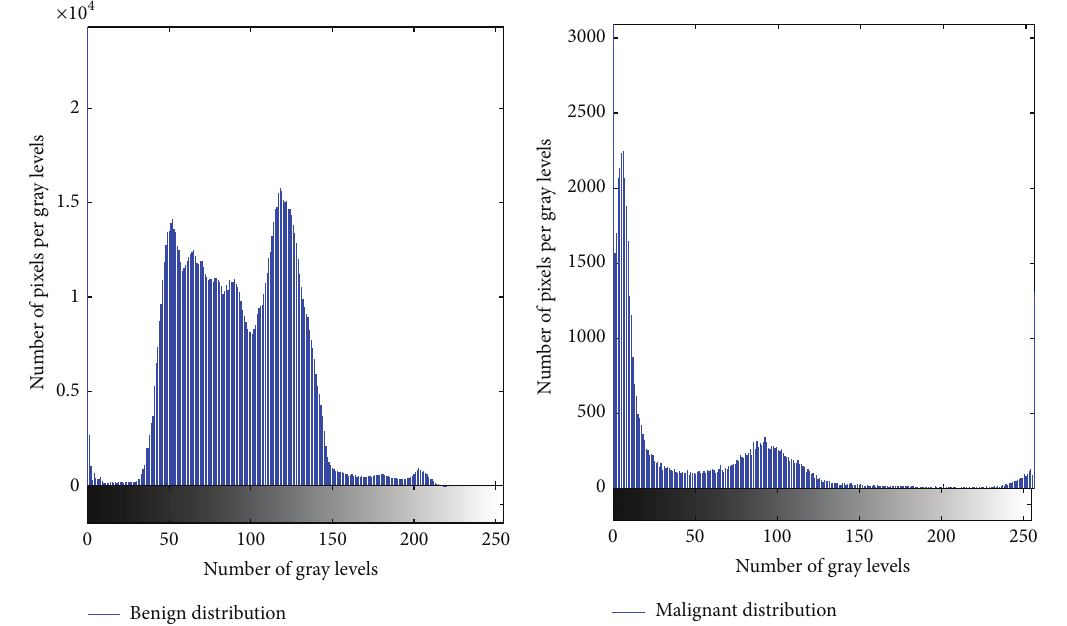
Figure 6: Histogram analysis of entropy feature